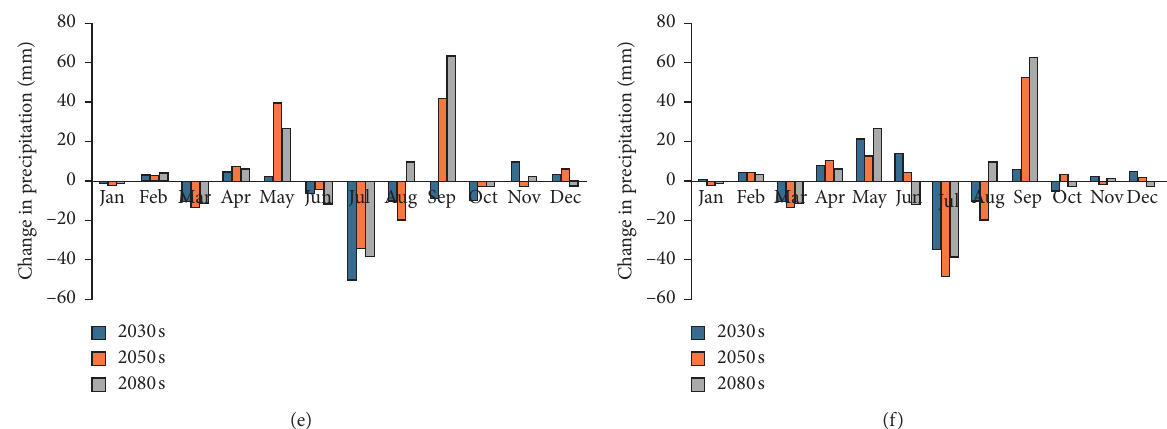
Figure 5: Changes in mean monthly ensemble. (a) For T max under RCP4.5. (b) For T max under RCP8.5. (c) For T min under RCP4.5. (d) For T min under RCP8.5. (e) For P under RCP4.5. (f) For P under RCP8.5.